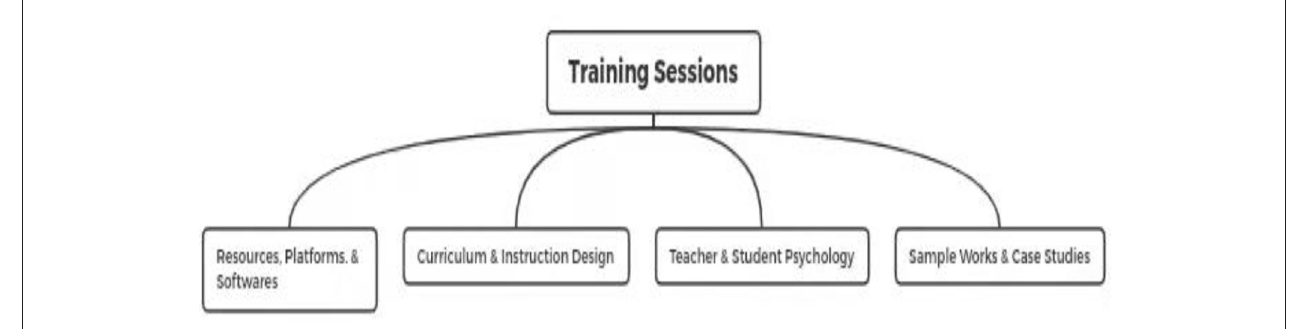
FIGURE 3 | Sufficient training